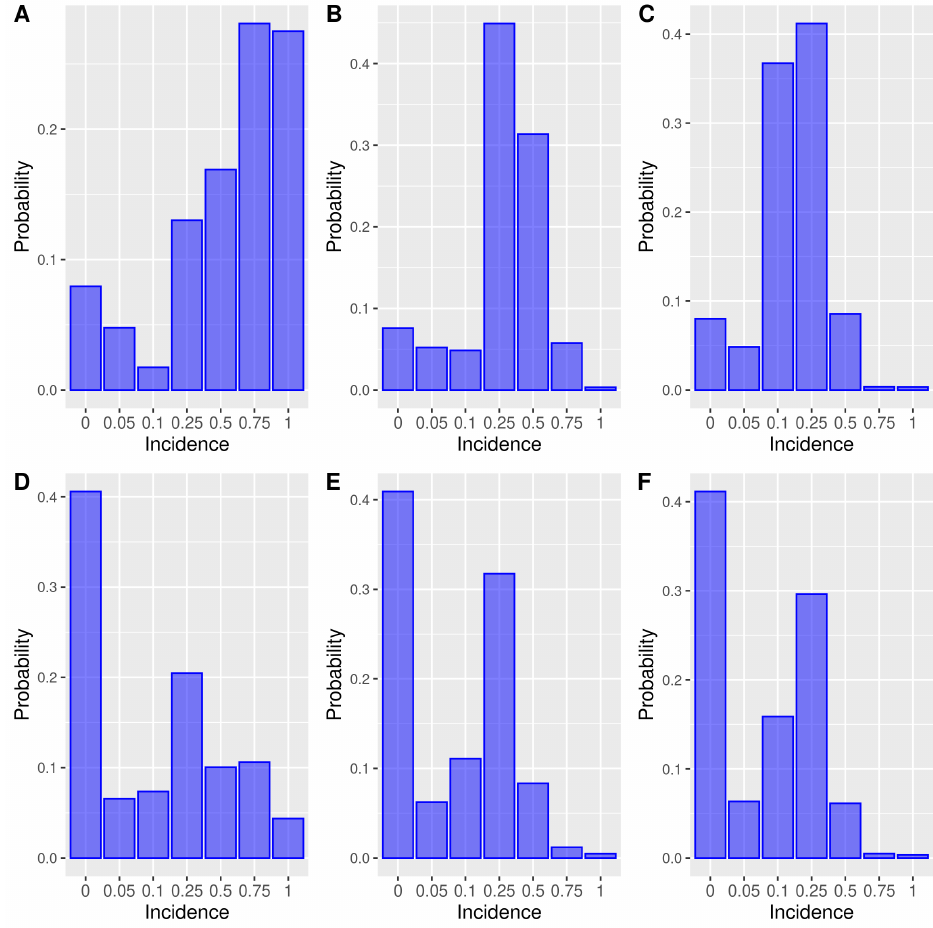
Figure 4. Probability distributions of each category of incidence for every quadruple ( c k , m , t , h ) s : ( A ) ( M = 0.10, H = O , T = O , C = 0 ) ; ( B ) ( M = 0.10, H = O , T = O , C = 1 ) ; ( C ) ( M = 0.10, H = O , T = O , C = 2 ) ; ( D ) ( M = 0.50, H = L , T = L , C = 0 ) ; ( E ) M = 0.50, H = L , T = L , C = 1 ) ; ( F ) ( M = 0.50, H = L , T = L , C = 2 ) . In Scenarios ( A – C ), where environmental conditions